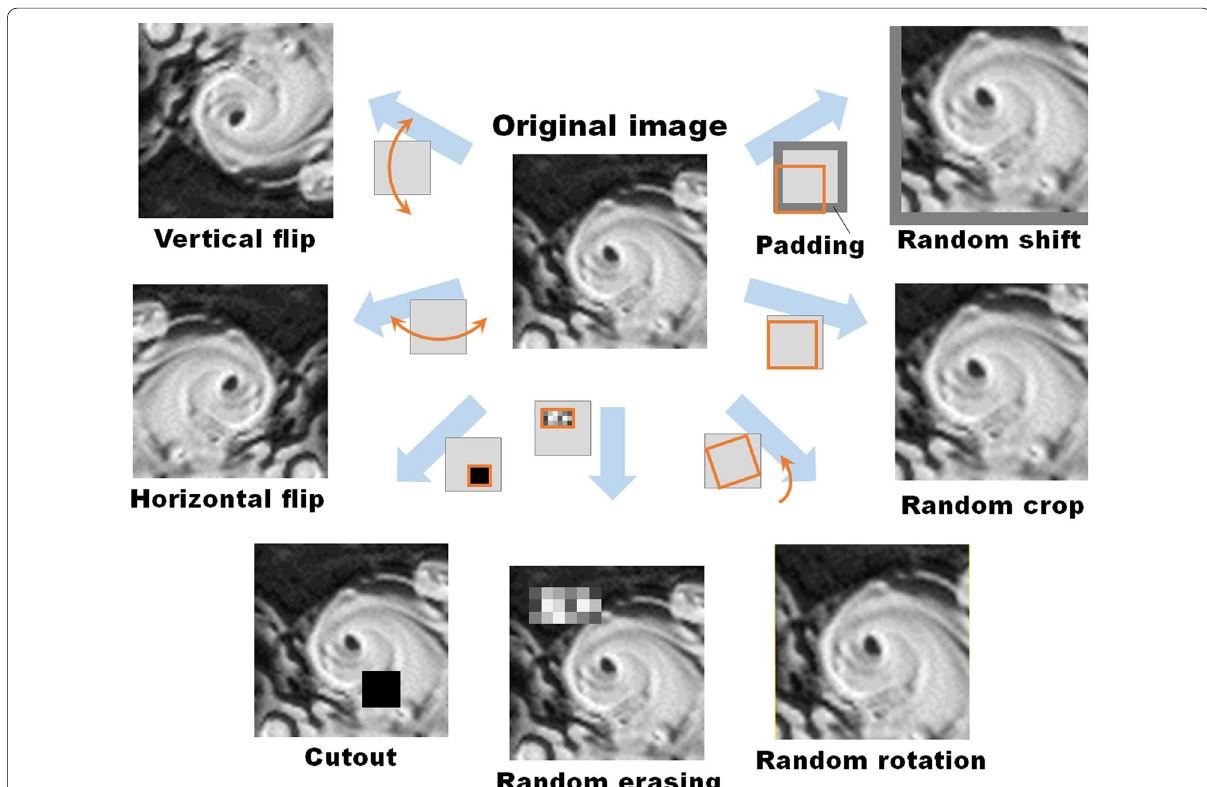
Fig. 3 Data augmentation for cloud image: vertical flip, horizontal flip, cutout, random erasing, random rotation, random crop, and random shift